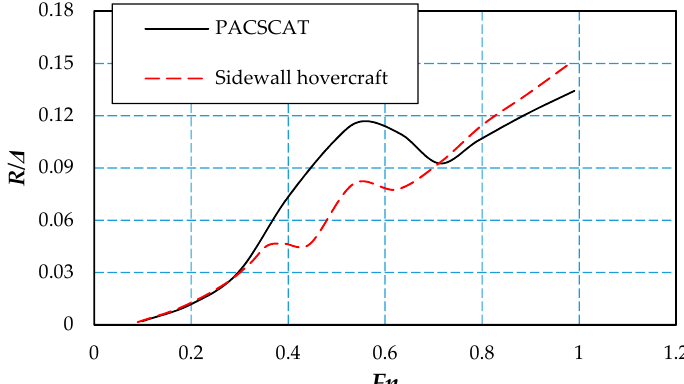
Figure 2. Non-dimensional resistance of PACSCAT and a sidewall hovercraft versus Froude number [1].